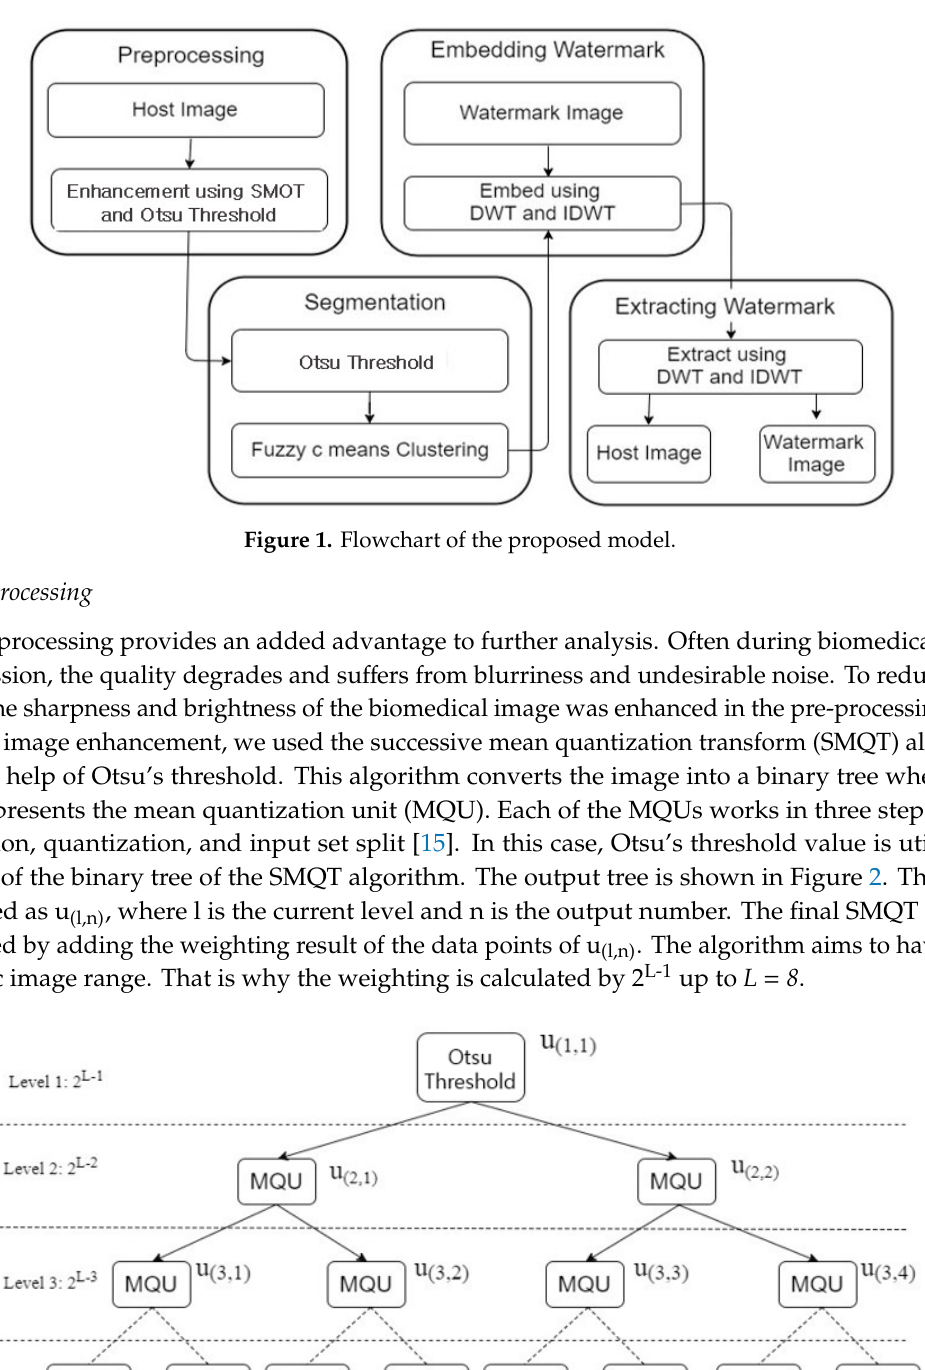
Figure 3. Host Image.